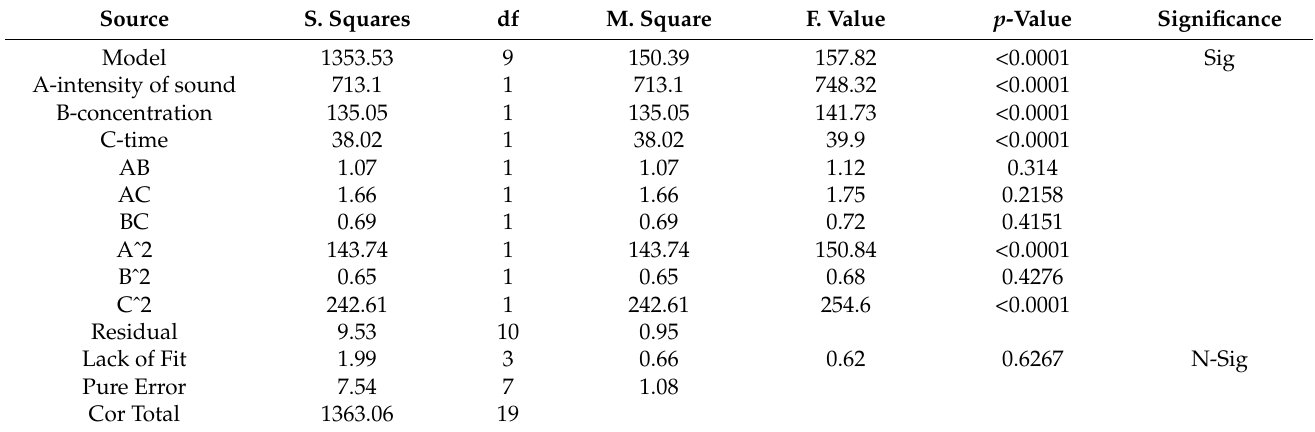
Table 5. ANOVA results for DPPH extraction.